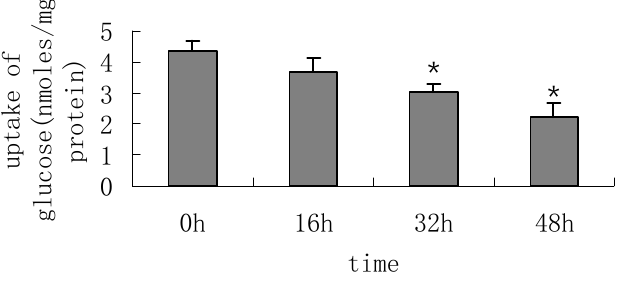
Figure 2. 1×10 6 cells were seeded in 12 wells multiplates, and cultured for 48 h until they reached confluence. Then the cells were treated with 5mmol/L sodium butyrate for 0 (without treating with sodium butyrate), 16, 32, 48h before glucose transport measurements. After washing, cells